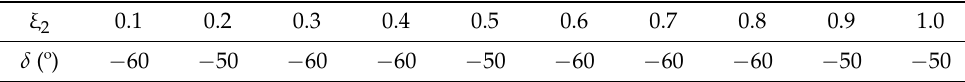
Table 5. Crack initiation angles (degree) calculated using finite element method when ϕ = 45 ◦